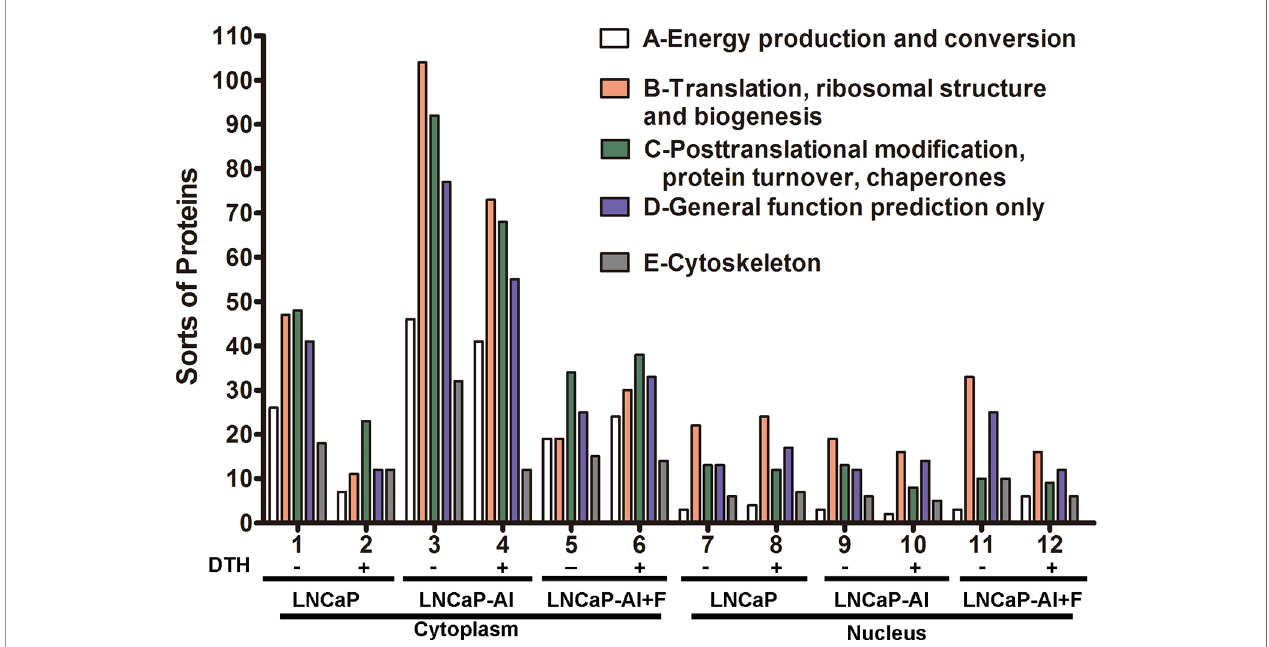
FIGURE 4 | COG functional annotation of the AR pull-down proteins in the three PCa cells. The x-axis indicates different classi fi cation groups, and the y-axis indicates the number of proteins in each COG class. (A – E) represent the fi ve most abundant COG categories: (A) -energy production and conversion; (B) -translation, ribosomal structure and biogenesis; (C) -posttranslational modi fi cation, protein turnover, and chaperones; (D) -general function prediction only; and (E) -cytoskeleton.